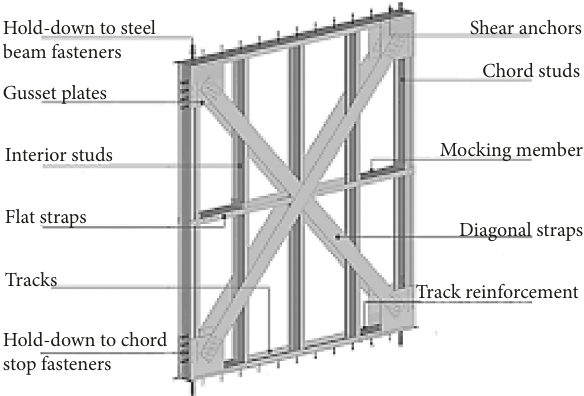
Figure 2: Cold-rolled steel frame components.